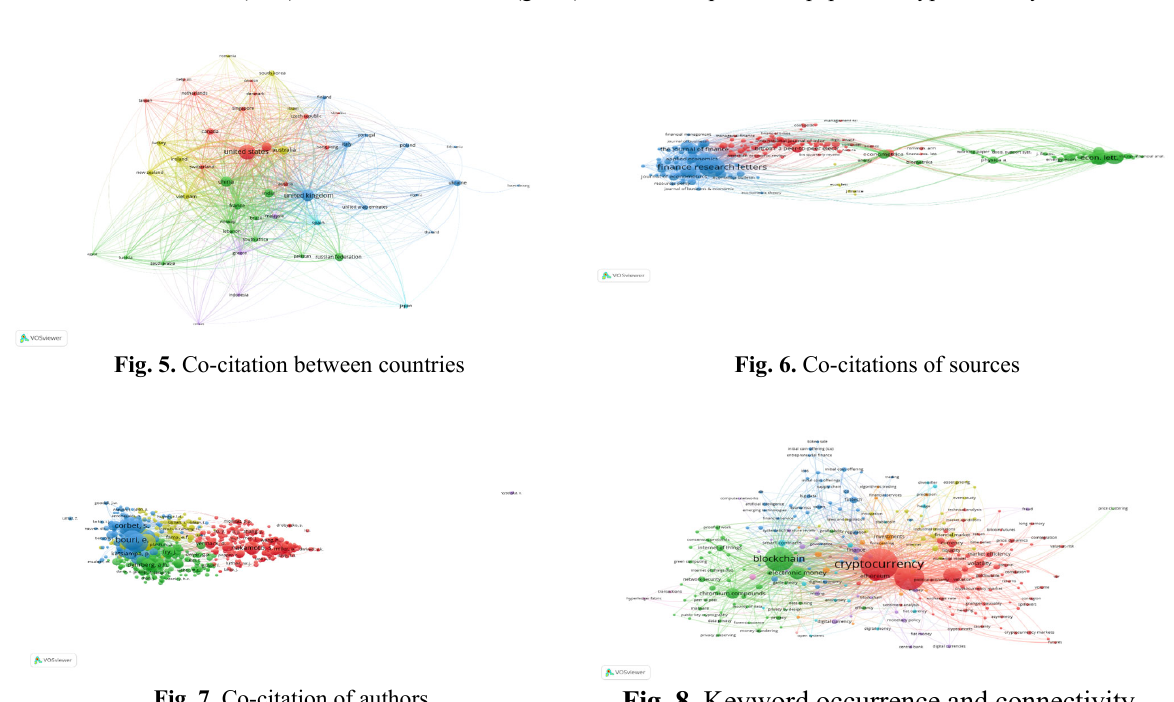
Fig. 7. Co-citation of authors Fig. 8. Keyword occurrence and